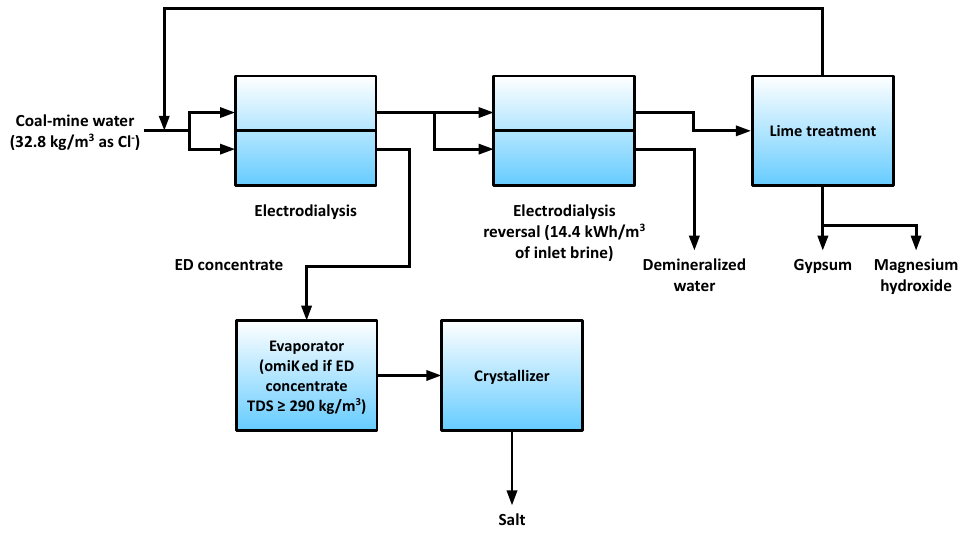
Figure 4. An overview of the proposed ED-EDR system [31].